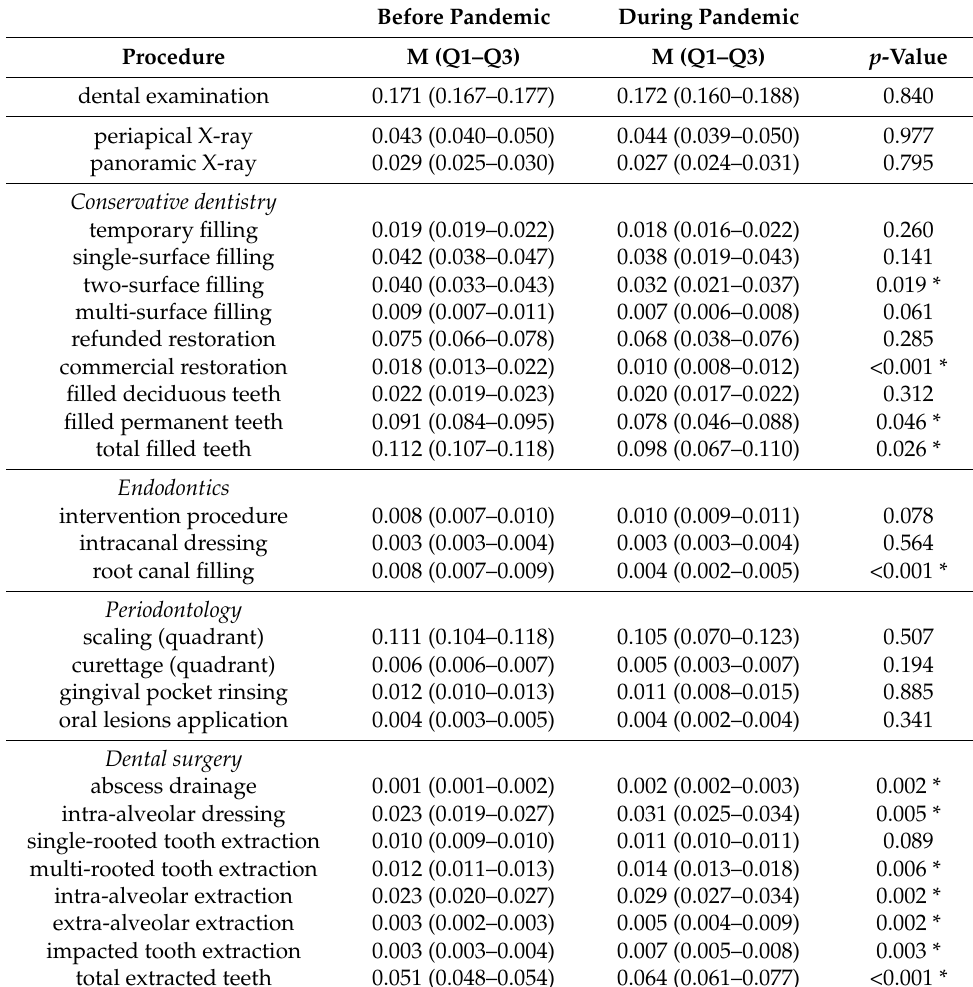
Table 1. Medians and quartiles for standardized numbers of selected procedures performed before and during the COVID-19 pandemic in the University Center of Dentistry and Specialized Medicine (Poznan, Poland) from 1 February 2019 to 31 January